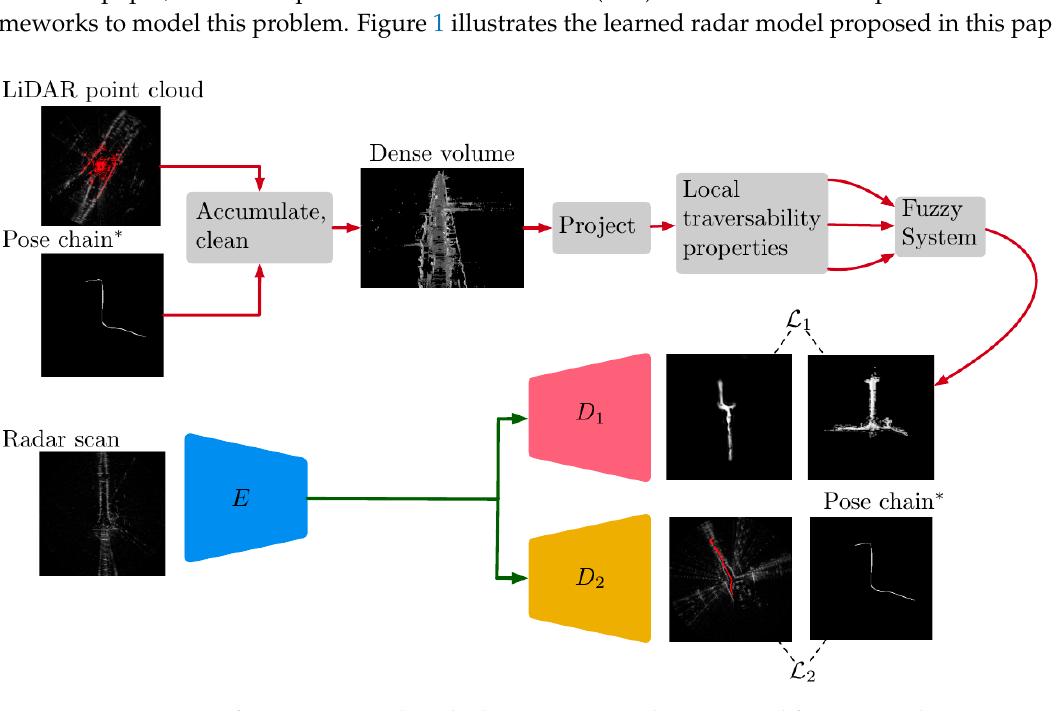
Figure 1. Overview of our system, as described in Sections 3 and 4. Data used for training the various models are shown top, with red lines indicating preparation of the labels. Various encoder-decoder paths bottom represent the various models proposed in this work, where ultimately in Section 4 we learn both loss objectives